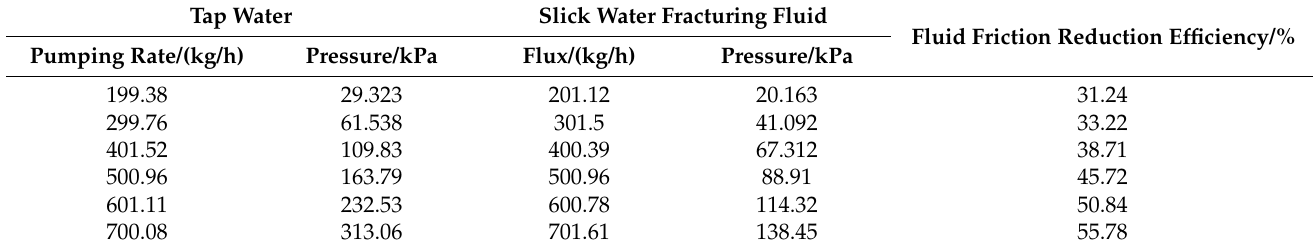
Table 7. Fluid friction reduction efficiencies for the slickwater fracturing